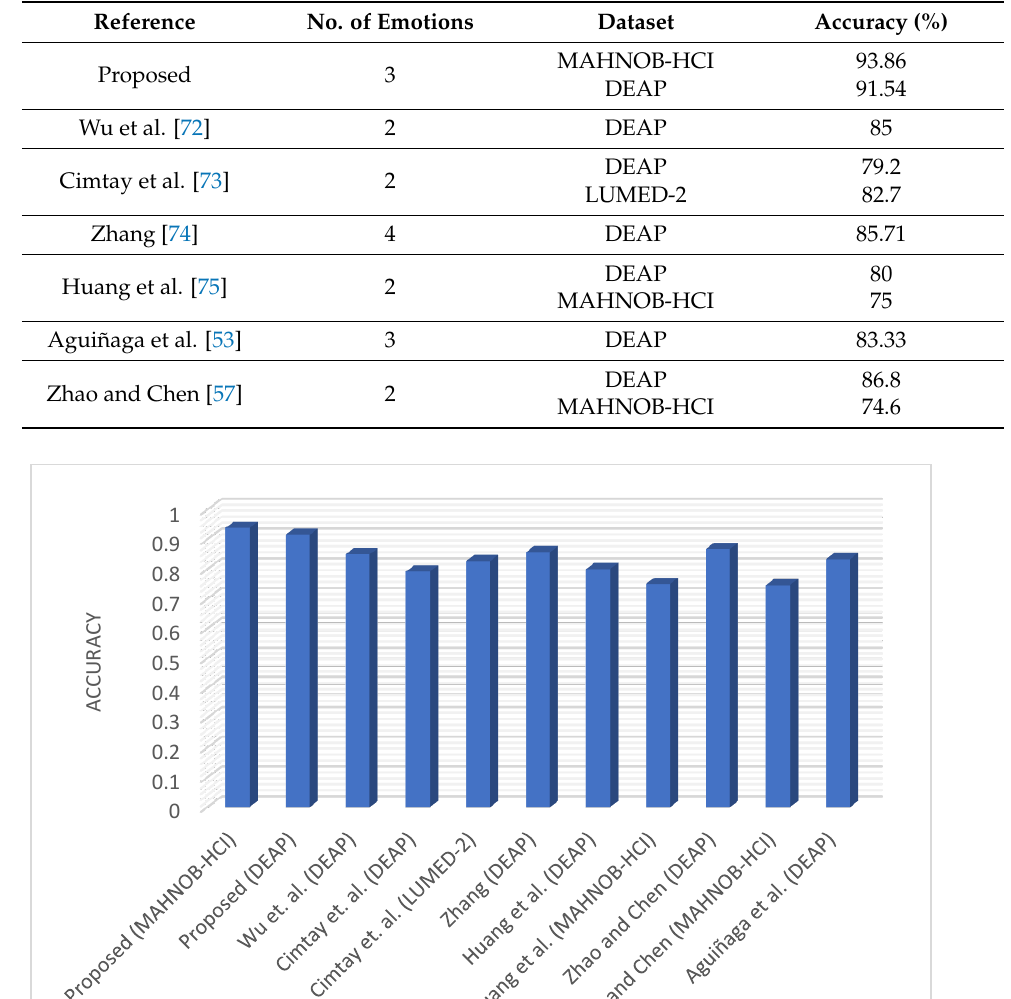
Table 11. Comparison of state-of-the-art methods in terms of accuracy reported in [11].